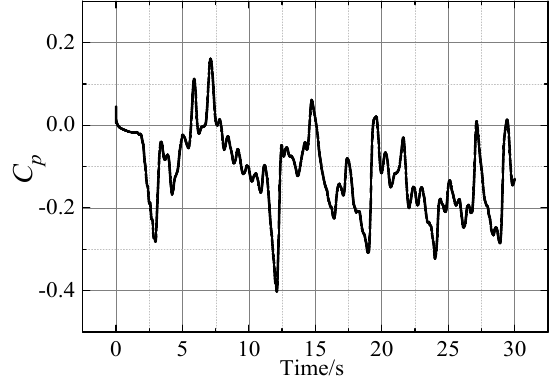
where x ( n ) is the original signal, T ( n ) is the undesired signal, χ ( n ) is the final testing original signal series.